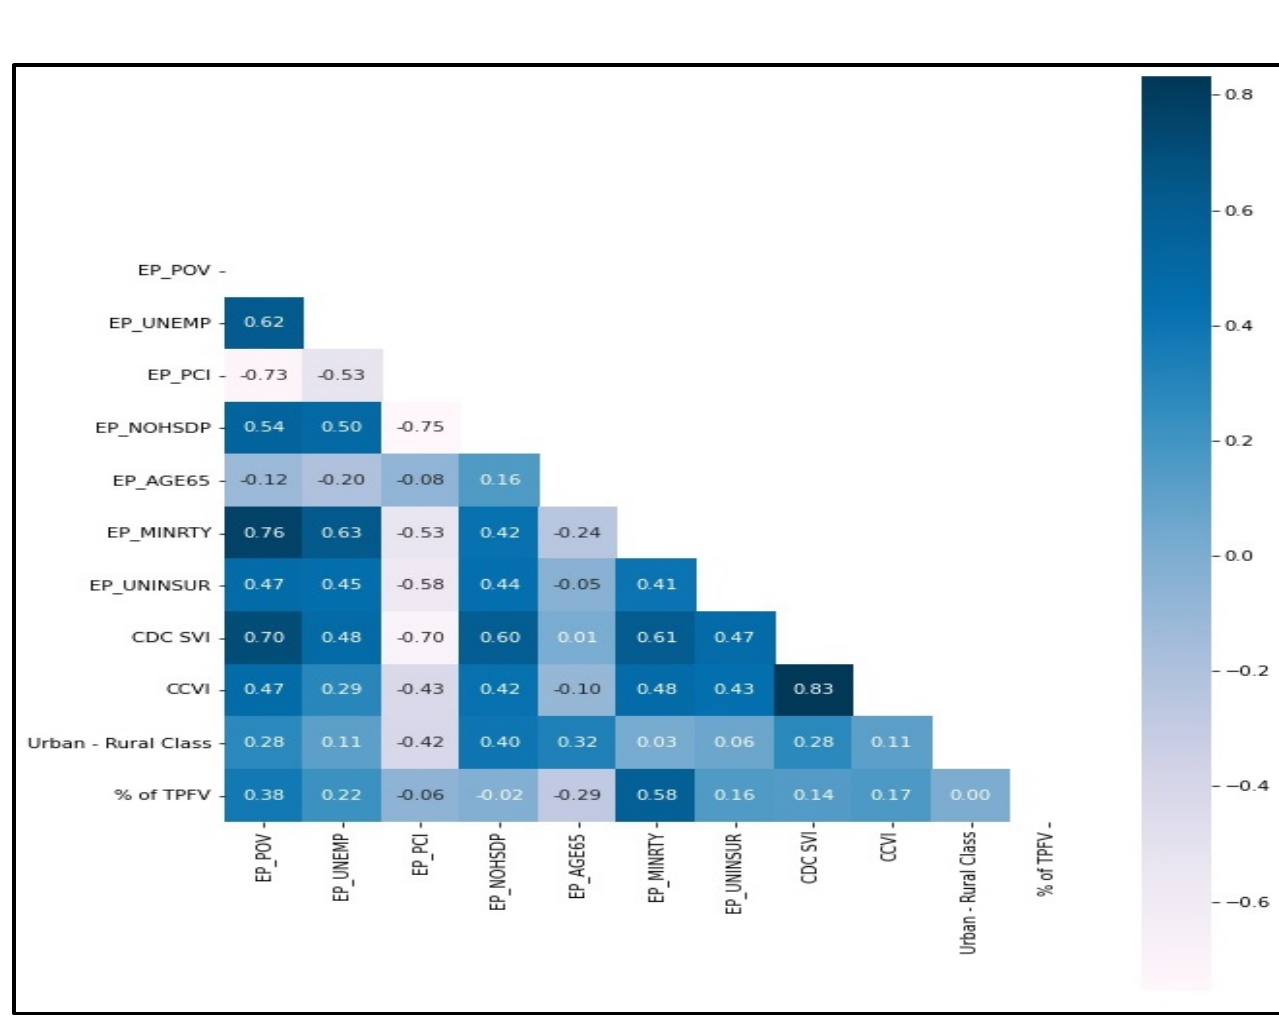
Figure 2. Heat Map Correlation Matrix of County-Level Features for County-Level Vaccination Rate.